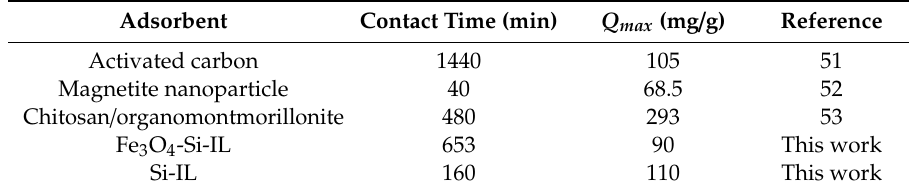
Table 4. A comparison of the adsorption performance of di ff erent adsorbents. Adsorbent Contact Time (min) Q max (mg / g) Reference Activated carbon 1440 105 51 Magnetite nanoparticle 40 68.5 52 Chitosan / organomontmorillonite 480 293 53 Fe 3 O 4 -Si-IL 653 90 This work Si-IL 160 110 This